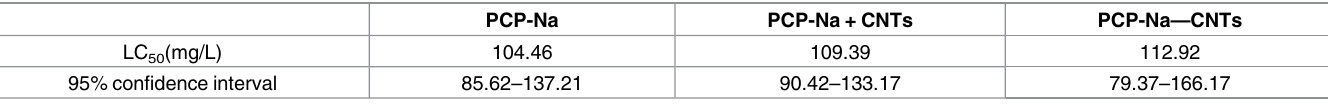
Table 2. Acute toxicity of PCP-Na to coelomocytes.